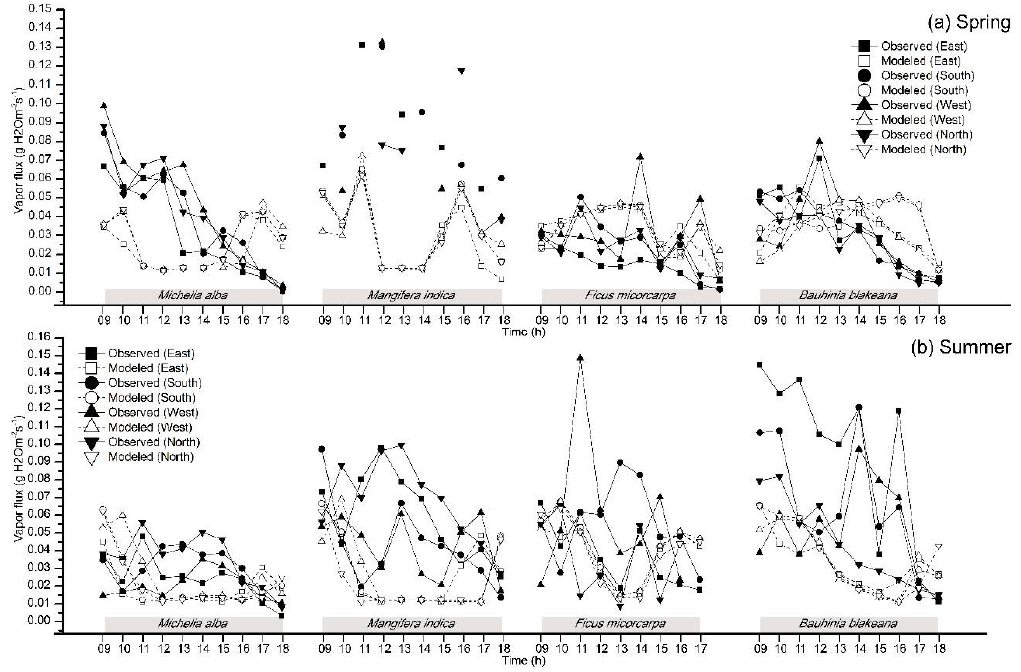
Figure 15. Comparison of modeled and observed vapor flux in four directions: ( a ) in spring; ( b ) in summer. The instrument did not operate properly on the measuring day for Mangifera indica , causing discontinuous observed values.